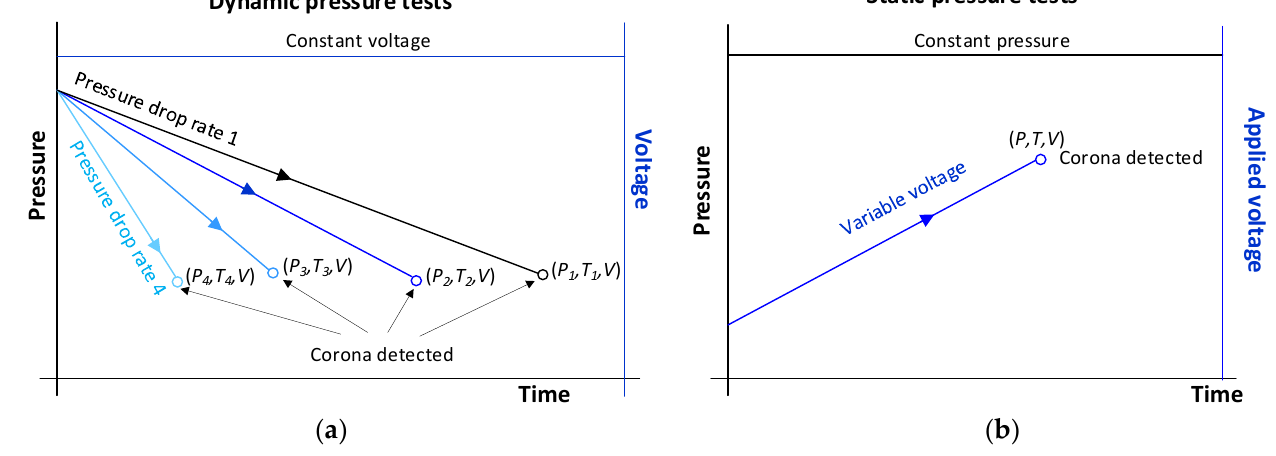
Figure 5. ( a ) Dynamic pressure tests. Tests conducted at constant applied voltage and various pressure drop rates. Voltage, pressure, and temperature were recorded at the inception of corona. ( b ) Static pressure tests. Tests performed at constant pressure and variable voltage amplitude.